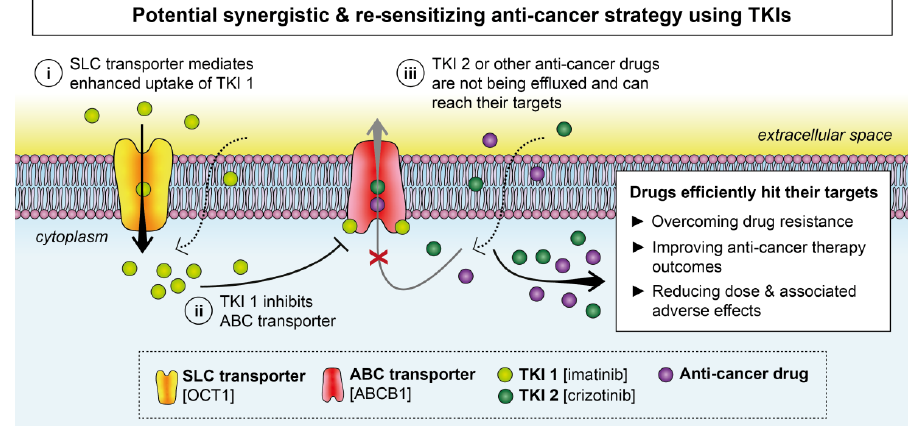
Figure 3. Schematic illustration of a potential anticancer strategy using TKIs that exploits the upregulated expression of SLC transporters to resensitize cells to anticancer drugs. In this scenario, high levels of certain SLC transporters (e.g., OCT1) are utilized to load a cancer cell with the first TKI (TKI 1; e.g., imatinib) ( i ). Apart from hitting its targets, TKI 1 also inhibits ABC transporters (e.g., ABCB1) ( ii ) so the second TKI (TKI 2; e.g., crizotinib) or other anti-cancer drugs are no longer effluxed from cancer cells ( iii ), which eventually results in synergistic effects of the drugs and improved treatment response.